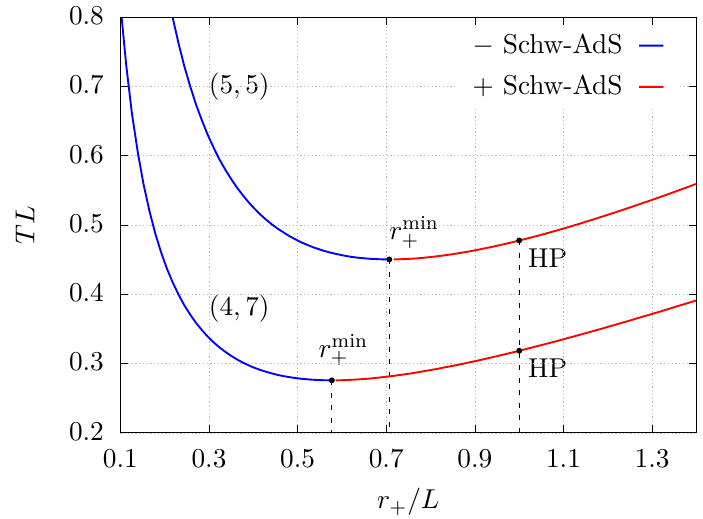
Figure 1. Dimensionless temperature vs. dimensionless control parameter for the relevant values ( p, q ) . The value at which the HP phase transition takes place is shown.